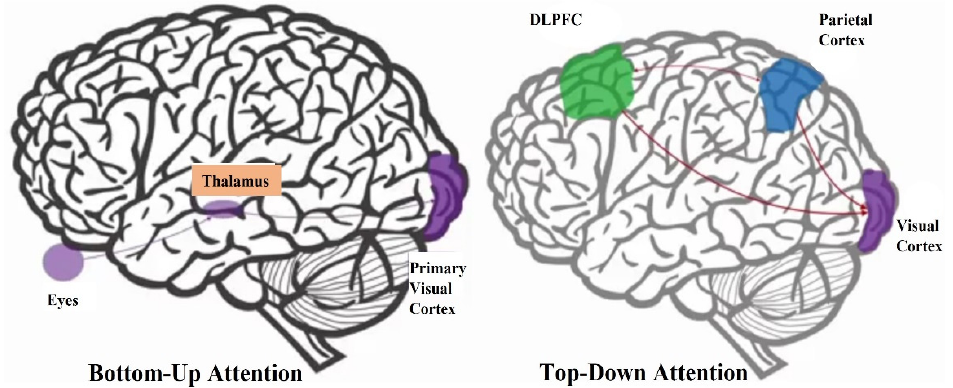
Figure 4. The bottom-up and top-down attention processes [59].